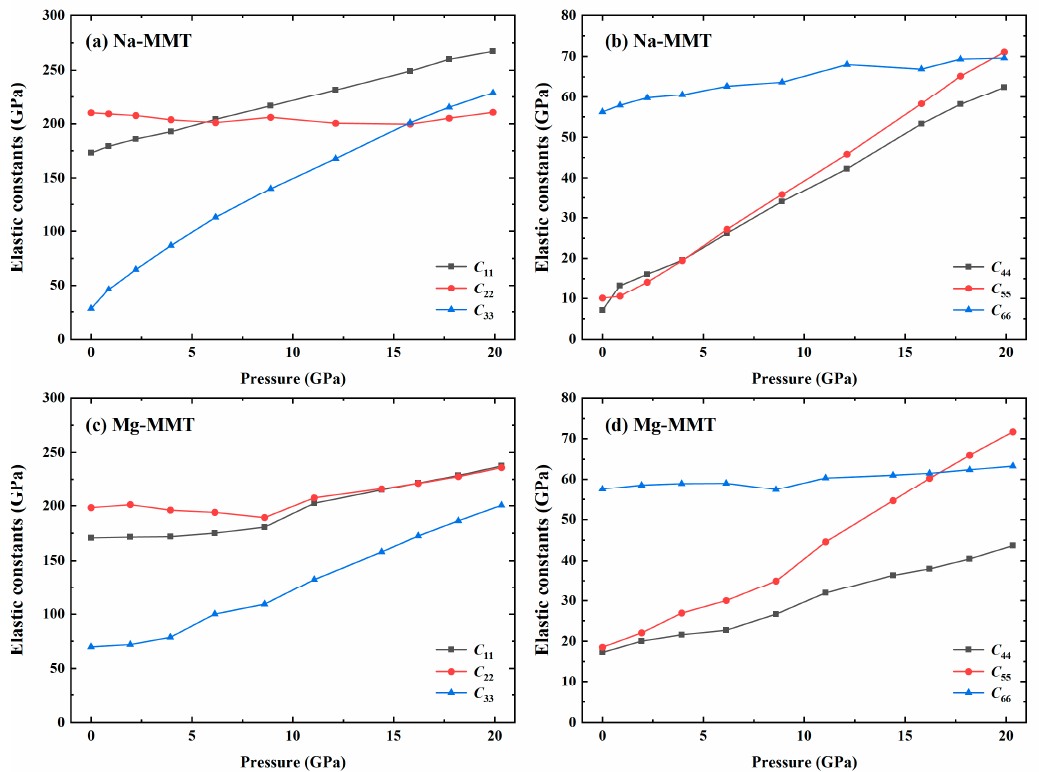
Figure 8. The calculated elastic constants ( C ij ) of the Na-MMT and Mg-MMT under different pressures. ( a ) Calculated value of C 11 , C 22 and C 33 of Na-MMT under given pressures; ( b ) calculated value of C 44 , C 55 and C 66 of Na-MMT under given pressures; ( c ) calculated value of C 11 , C 22 and C 33 of Mg-MMT under given pressures; ( d ) calculated value of C 44 , C 55 and C 66 of Mg-MMT under given pressures.